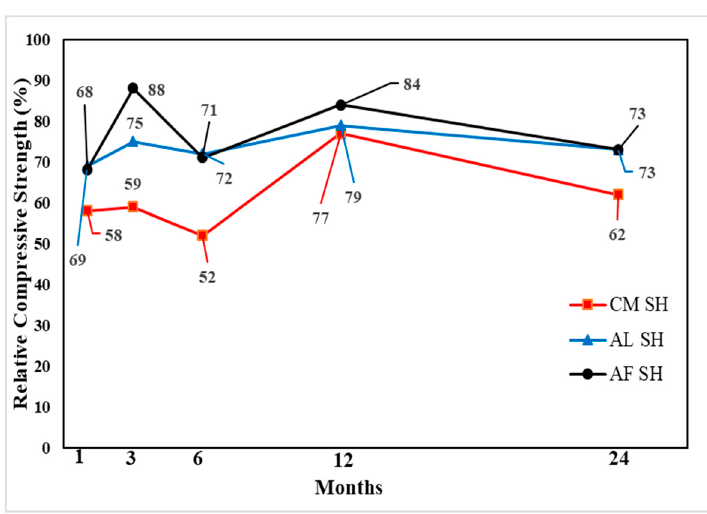
Figure 15. Alkali-free (AF) accelerator mix compressive strength by age.